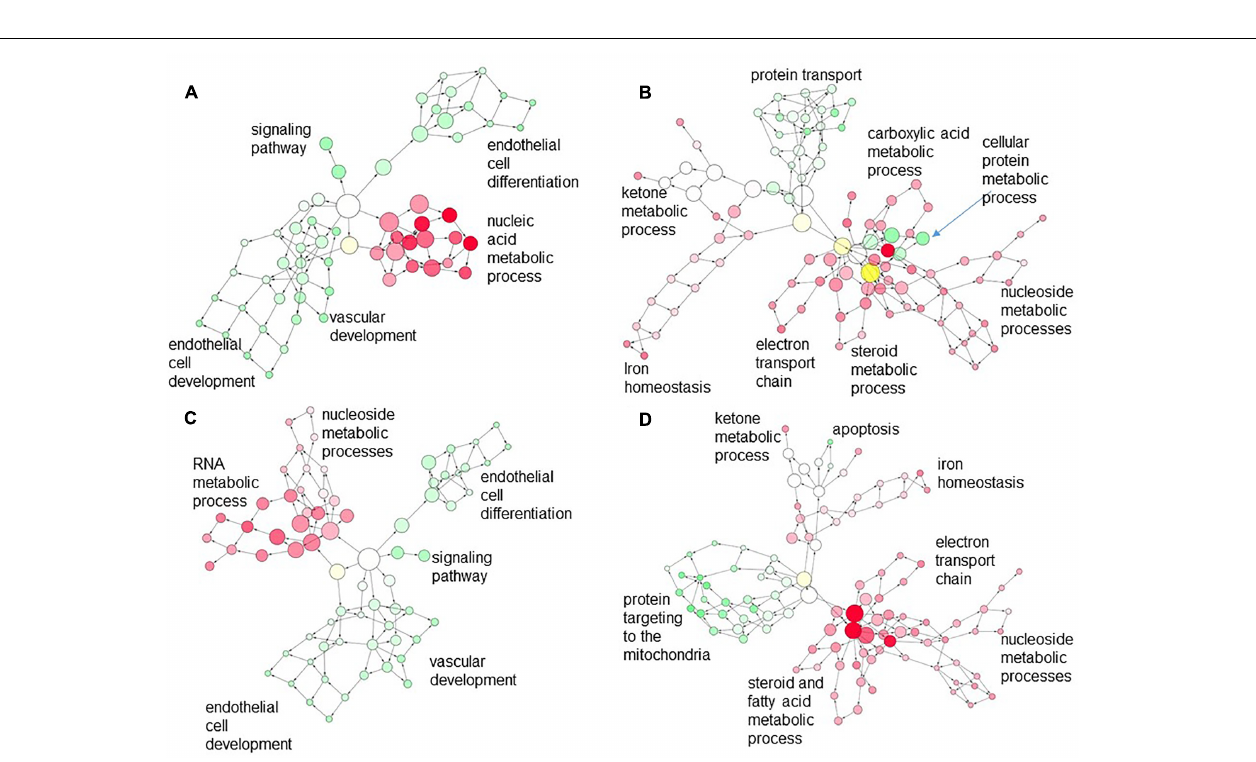
FIGURE 4 | Merged network created in Cytoscape depicting interaction of the gene ontology (GO) terms associated with (A) down-regulated genes in the LV (red) and upregulated genes in the EAT (green); (B) upregulated genes in the LV (green) with downregulated genes in the EAT (red); (C) down-regulated genes in the IVS (red) with upregulated genes in the EAT (green); (D) upregulated genes in the IVS (green) with downregulated genes in the EAT (red). Each circle is a node that corresponds to a GO term. Nodes size is proportional to the number of genes associated with that GO term. Nodes are connected by edges; edge length is inversely proportional to the degree of association of the connected nodes. Density of the color in the nodes is proportional to the level of statistical significance. Higher order (most specific) GO terms appear at the periphery of the network.